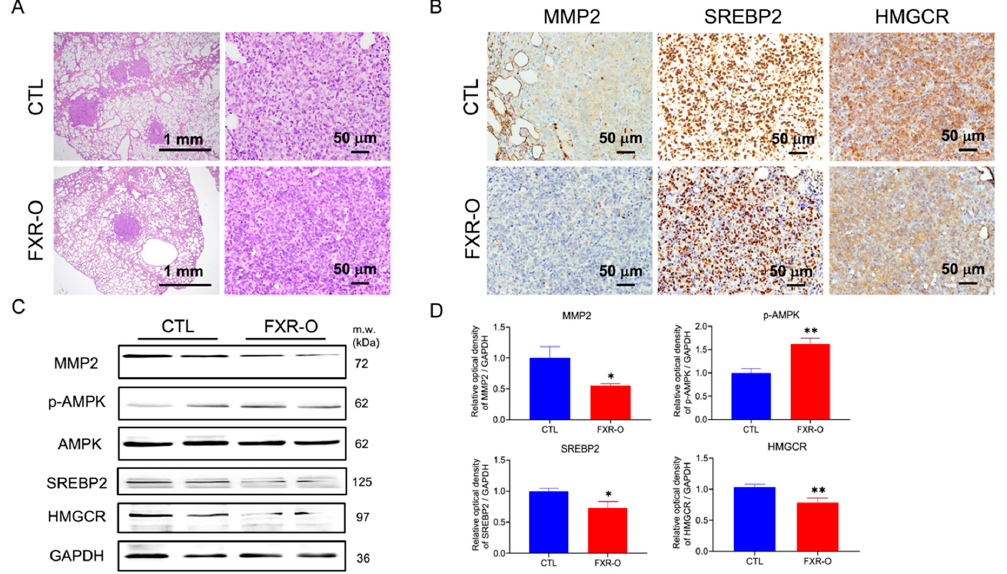
Figure 5. The effect of FXR overexpression on cholesterol biosynthesis-related protein expression in lung tissues of the xenograft model. ( A ) Lung tumors were observed by hematoxylin and eosin staining. Scale bar = 1 mm and 50 µm. ( B ) Immunohistochemical analysis of MMP2, SREBP2 and HMGCR expression in lung tissues from the control and FXR-O groups. Scale bar = 50 µm. ( C ) MMP2, p-AMPK, AMPK, SREBP2 and HMGCR protein expression was measured by Western blotting analysis. ( D ) The relative quantitative analysis of these proteins was shown by bar graphs. * p < 0.05; ** p < 0.01 compared to the control group. The original blots are shown in Figure S6B. 3.5. The HMGCR Inhibitor Atorvastatin Enhanced the FXR Overexpression-Mediated Decreases